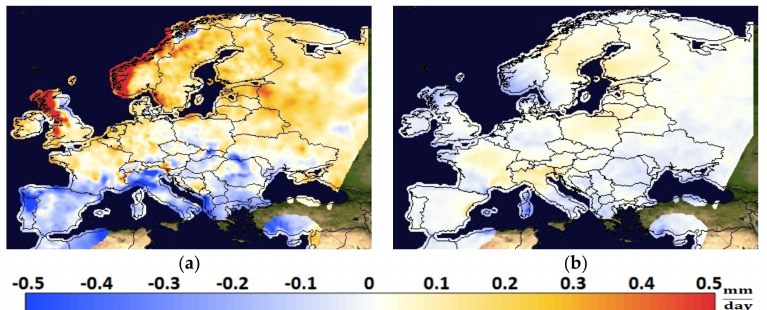
Figure 5. Mean daily precipitation change between current (1981–2010) and historic (1951–1980)